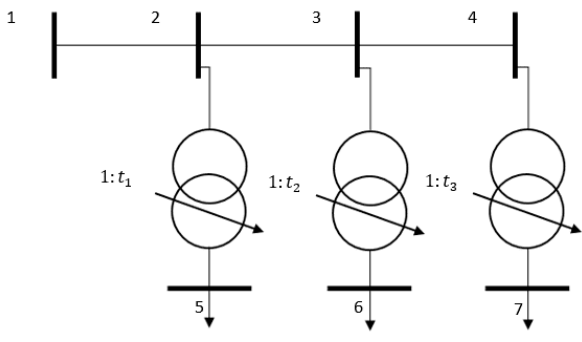
Figure 3. Seven-bus test network for proof of concept.